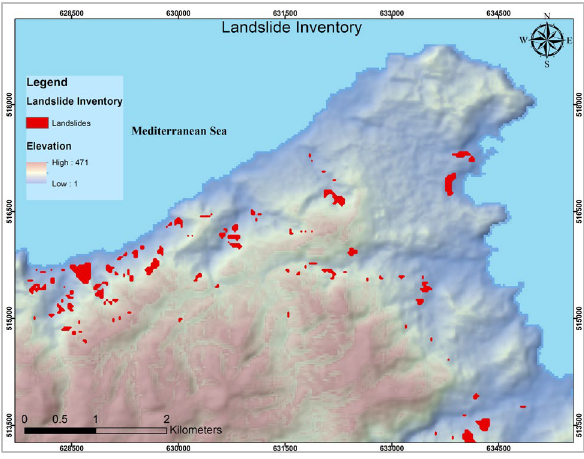
Figure 2. Distribution of landslides occurrence in Al Hoceima and its